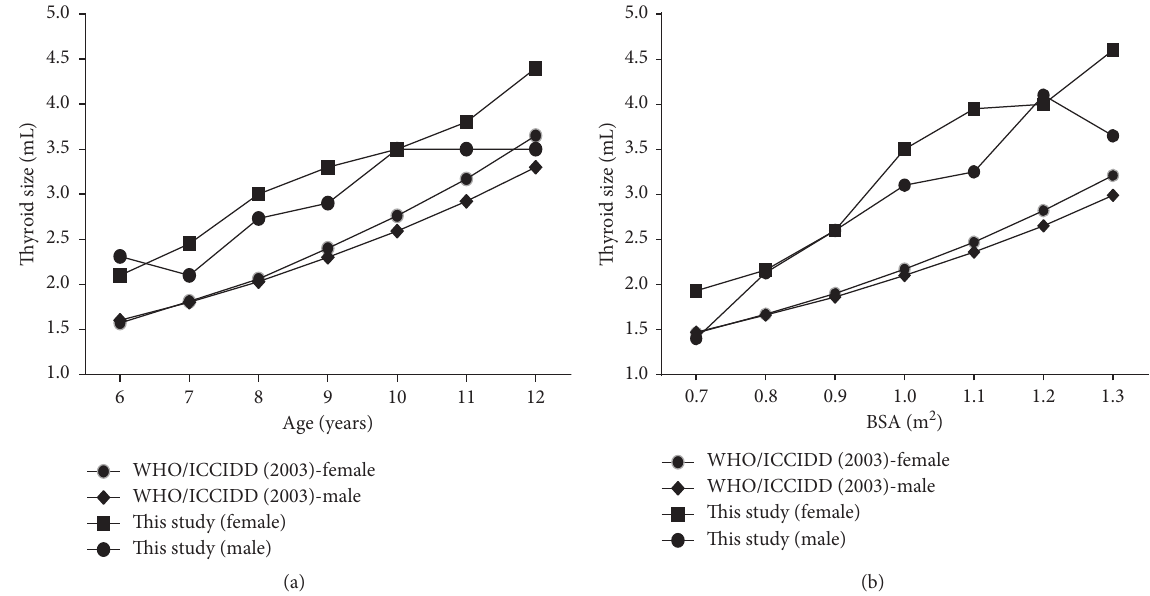
Figure 5: (a) Median (P50) thyroid volume according to age among school-aged children (6–12 years) in the Ashanti region of Ghana, compared with international reference data. (b) Median (P50) thyroid volume according to body surface area (BSA) among school-aged children (6–12 years) in the Ashanti region of Ghana, compared with international reference